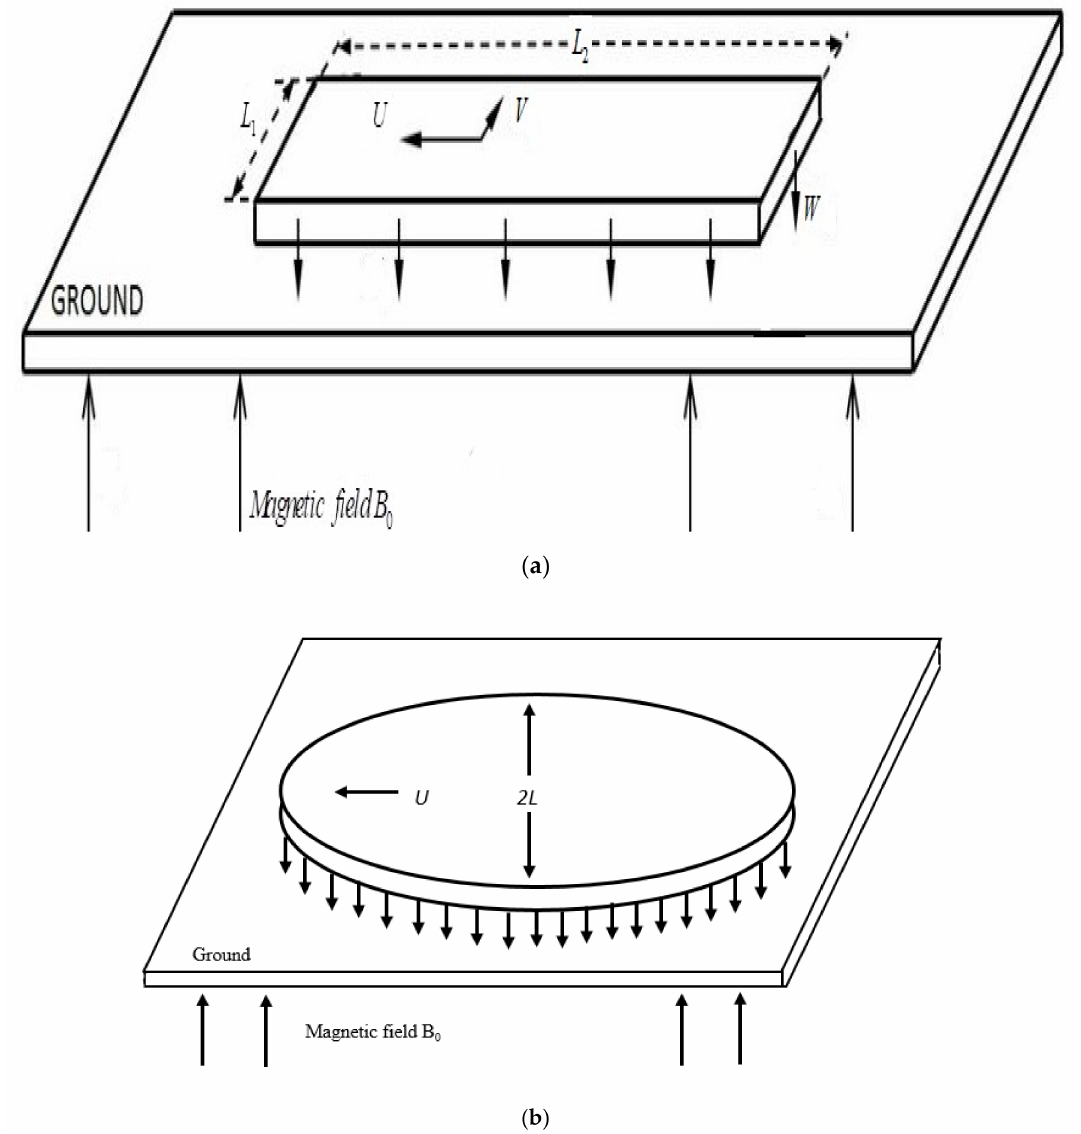
Figure 1. ( a ) Schematic diagram of the movement of a long porous slider (LPS). ( b ) Schematic diagram of the movement of a circular porous slider